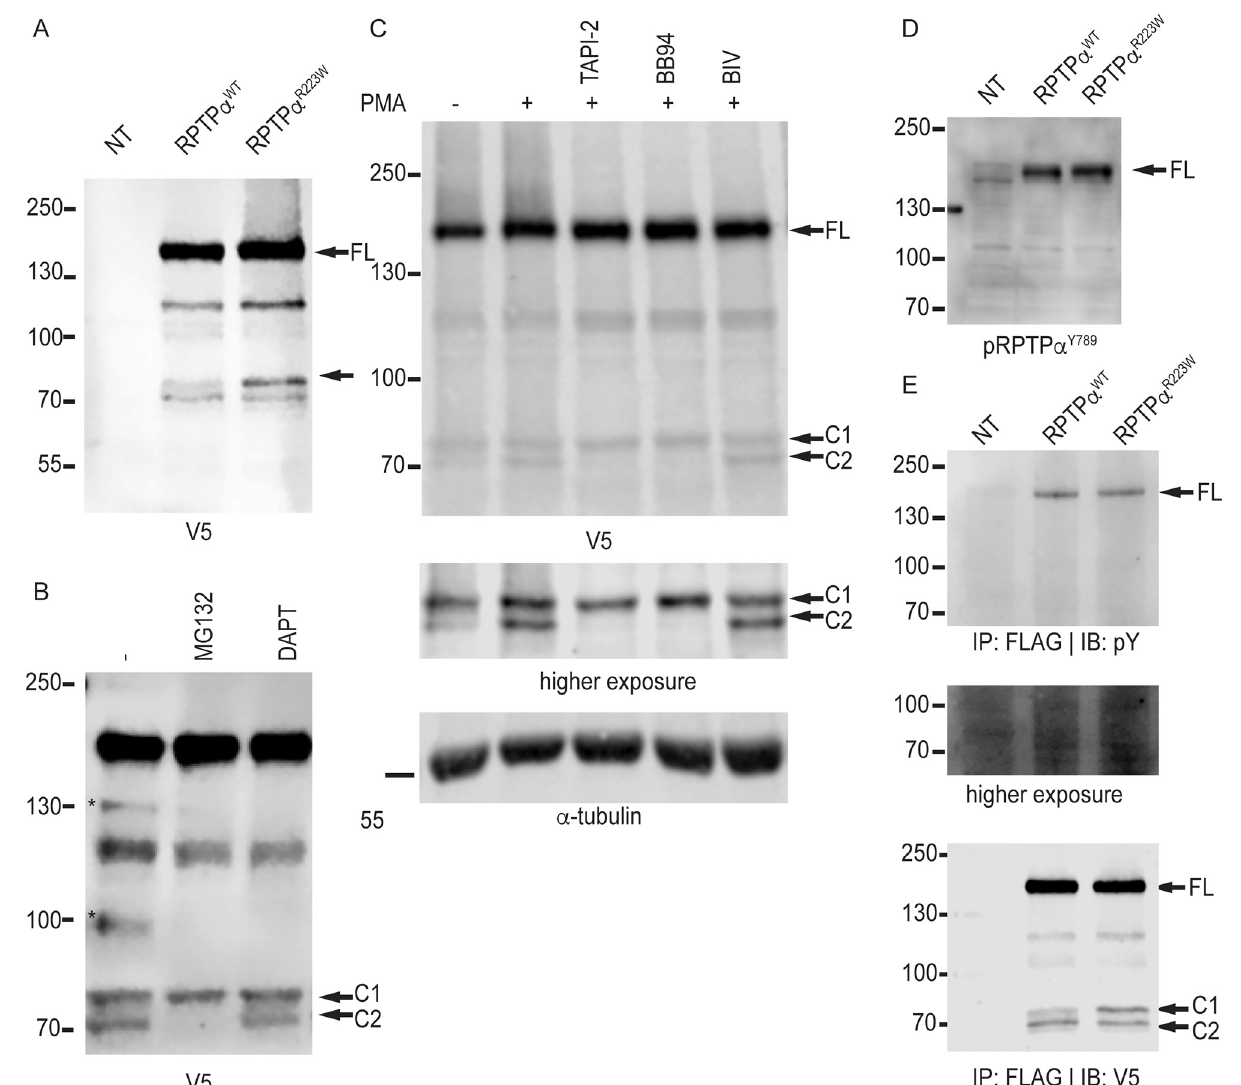
Fig 3. (A) Immunoblot of RPTP α WT and RPTP α R223W transfected HEK293T cells. Arrow indicates RPTP α R223W specific ~75 kDa band. (B) Immunoblot of RPTP α R223W transfected HEK293T cells treated with MG132 or DAPT for 4 hours. (C) Immunoblot of RPTP α R223W